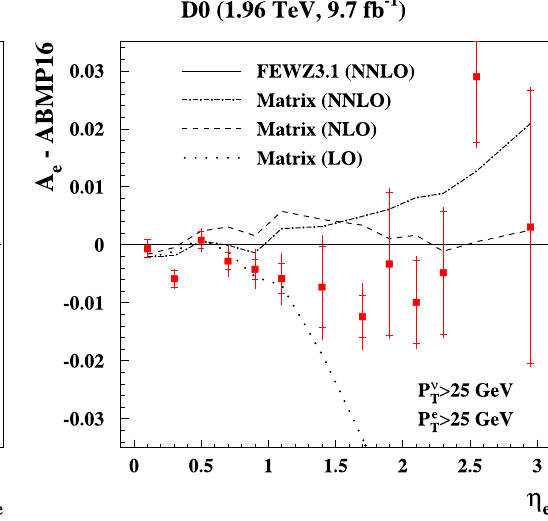
-cuts of the decay lep- T